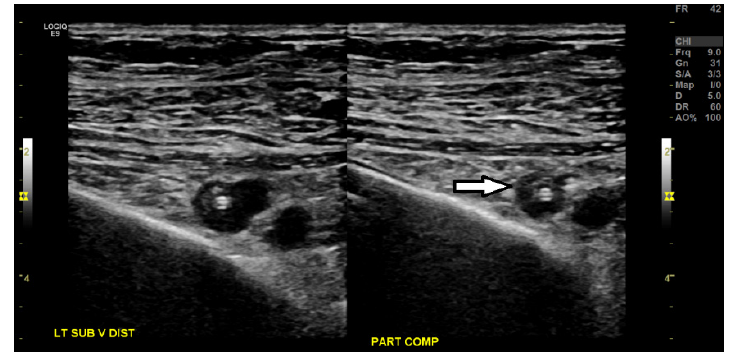
Figure 5. Ultrasound venous duplex imaging of the bilateral upper extremities shows an acute, partially occlusive deep-vein thrombus within the left subclavian vein along an indwelling venous catheter (white arrow).